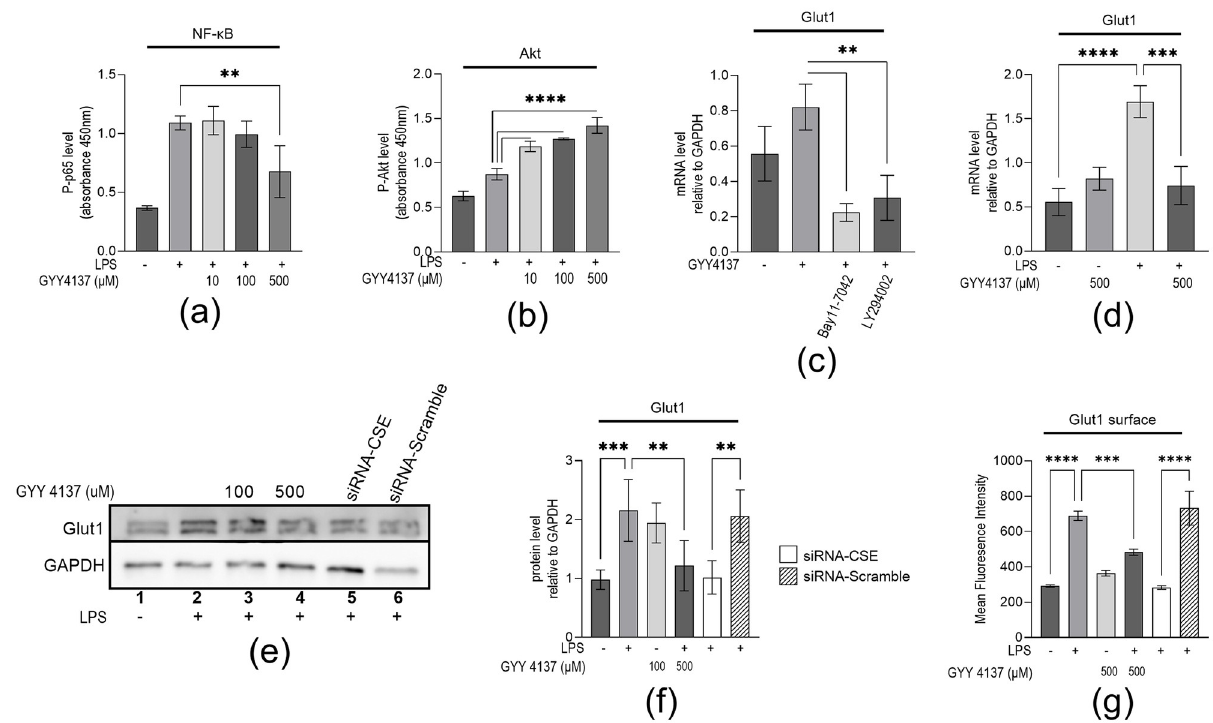
Fig 4. H 2 S decreased LPS-induced NF- κ B activation and increased Akt activity which is associated with Glut1 mRNA, protein, and surface expression on macrophages. ( a – b ) RAW264.7 cells were treated simultaneously with indicated concentrations of GYY4137 and LPS. (Panel a and b ) RAW 264.7 cells were analyzed by ELISA targeting Phospho-p65 (NF- κ B subunit) (panel a ) or Phospho-Ser473 (Akt subunit) (panel b ). ( c ) RAW264.7 cells were initially treated with IKK-inhibitor Bay11-7042 (15 μ M) or PI3k inhibitor LY7294002 (25 μ M) (for 1 h) and then treated with 500 μ M GYY4137 for an additional 4 h for RNA. RT-qPCR analyzed RNA for the expression of Glut1 (panel c ). GAPDH was used as a control. ( d ) RAW264.7 cells were treated with LPS and 500 μ M GYY4137 for 4 h for RNA. RT-qPCR analyzed RNA for the expression of Glut1 (panel d ). GAPDH was used as a control. ( e — f ) RAW264.7 cells were transfected (24 h) with CSE-siRNA or Scramble-siRNA, followed by treatment with GYY4137 and LPS for 4 h. RAW264.7 cells were analyzed by Western blotting using antibodies against Glut1 and GAPDH (loading control) (panel e ). The changes in amounts of Glut1 have been quantified by ImageJ software and shown in panel ( f ). ( g) RAW264.7 cells were transfected (24 h) with CSE-siRNA or Scramble- siRNA, followed by treatment with GYY4137 and LPS for 4 h. RAW264.7 cells surface staining were analyzed by flow cytometry using antibodies against Glut1 and secondary antibodies conjugated with R-PE (565/590 nm). Data represent mean ± SD (n = 3); �� p < 0.001, ��� p < 0.0001, ���� p <